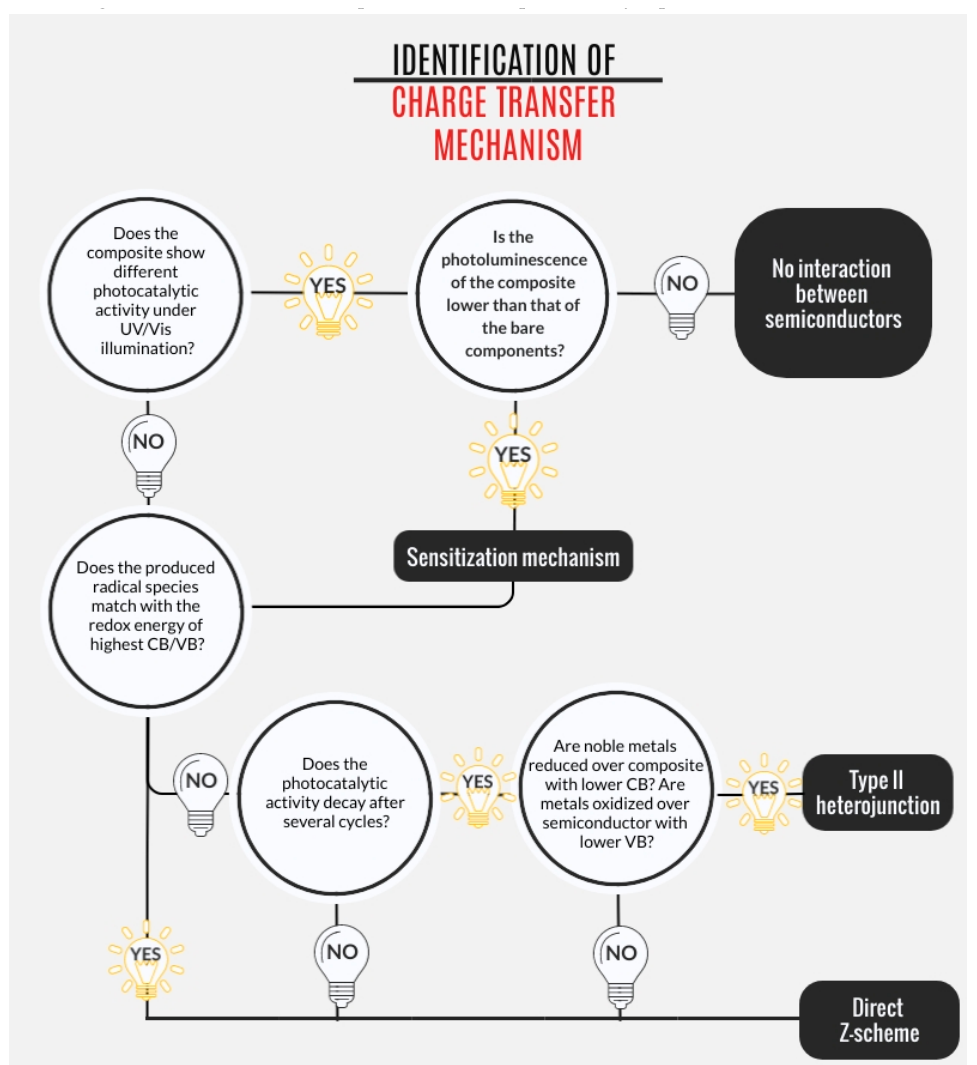
Figure 10. Decision-making diagram for charge transfer mechanism discrimination.